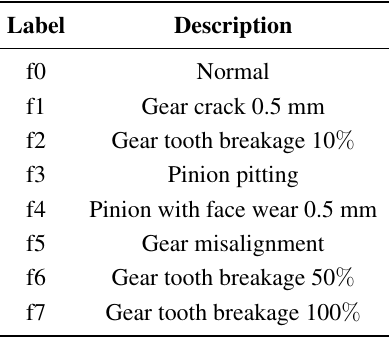
Table 1. Simulated gear